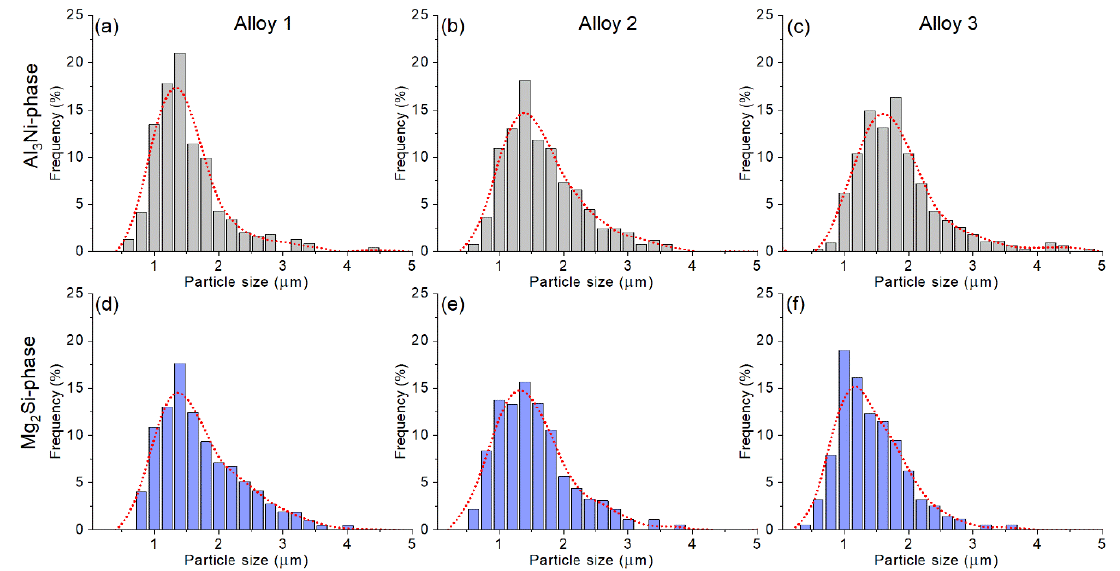
Figure 7. The particle size distribution histograms of the ( a – c ) Al 3 Ni and ( d – f ) Mg 2 Si phases for the thermomechanical treated ( a , d ) alloy 1 (Al-1.2Mg-0.7Si-1.0Cu-0.5Ni), ( b , e ) alloy 2 (Al-1.2Mg-0.7Si-1.0Cu-2Ni), and ( c , f ) alloy 3 (Al-1.2Mg-0.7Si-1.0Cu-4Ni).